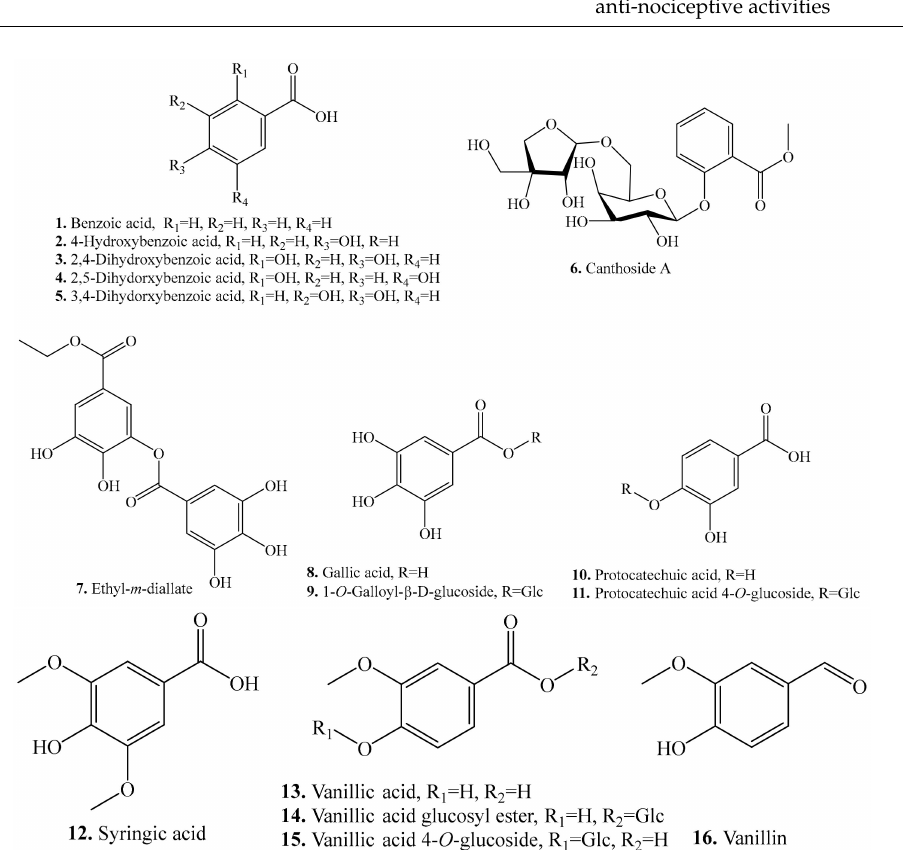
Figure 1. Structures of the benzoic acid analogues isolated from